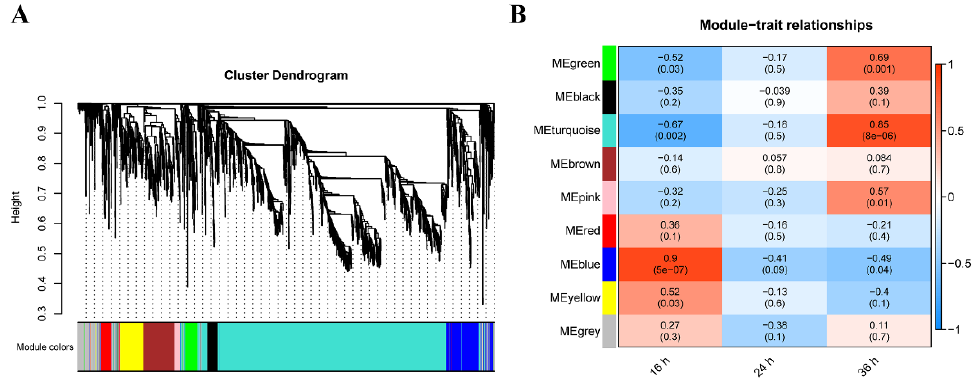
Figure 4. Weighted gene co-expression network analysis of differentially expressed genes. ( A ) Hierarchical clustering tree of DEGs by WGCNA. ( B ) Module–time relationships. The value above the box represents the correlation coefficient between the module and time, and the value below represents the significance between them.